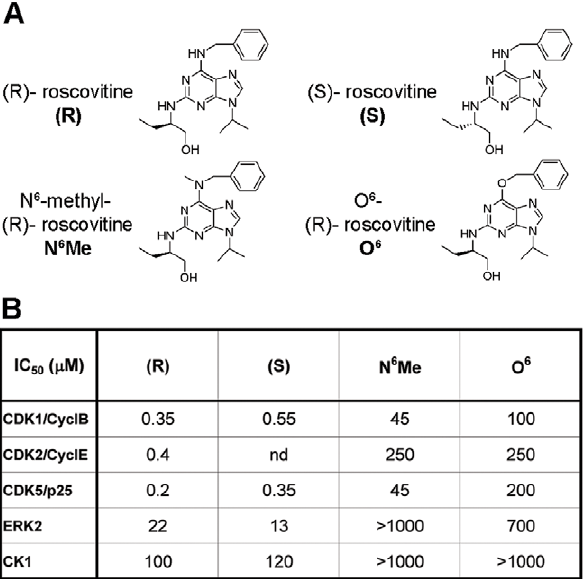
Figure 5. Structure of roscovitine analogs used in this study. ( A ) Structure of (R)- and (S)- stereoisomer of roscovitine, as well as N 6 - methyl (R)-roscovitine and O 6 -(R)-roscovitine that are two compounds designed for their inability to inhibit CDKs [30] ( B ) IC 50 values (in m M) previously described for these compounds [30,31]. nd: not determined.